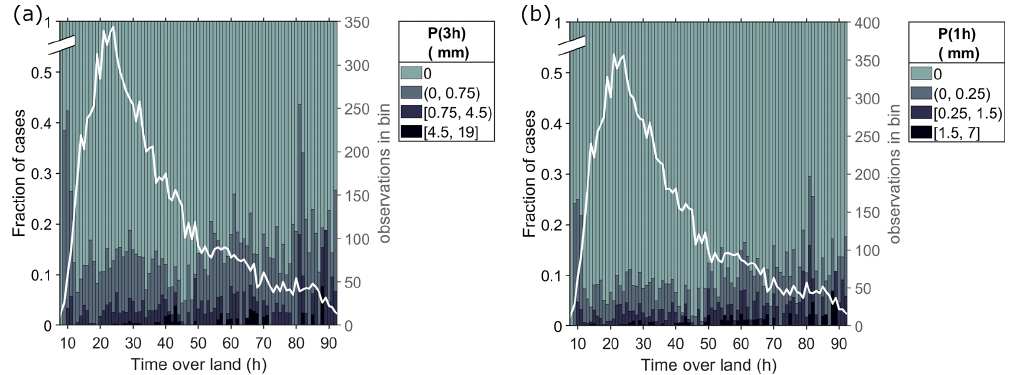
Figure 9. Fraction of rainfall in the next (a) 3h and (b) 1h in four different value ranges as a function of ToL of the arriving air mass. There is a break in the y axis so that distinguishing the detail of precipitating fractions is easier. The white lines and the right y axes show the number of observations in each bin. Here the value groups were manually selected and not based on percentiles. The rainfall value ranges are also different between the figures, with the 3h precipitation limits being triple the 1h limits. One outlier was excluded from panel (b) (18mm).